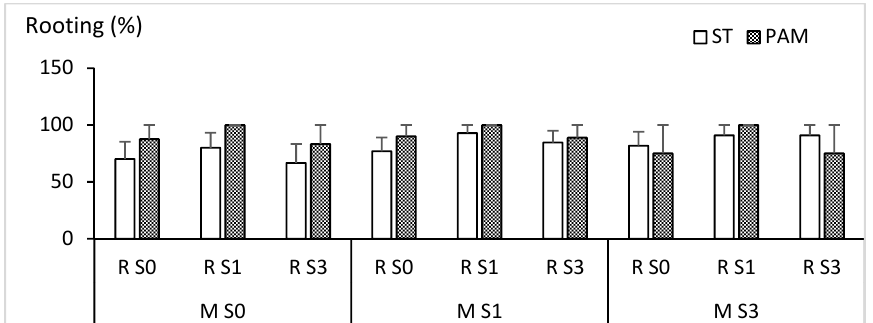
Figure 12. Shoots of CBP cultured in RITA© with 0–3% sucrose in ST or PAM conditions and rooted in rockwool cubes soaked with 0–3% sucrose. ST: standard conditions and PAM: photoautotrophic conditions. M S0, M S1 and M S3: sucrose percentage (0, 1 or 3%) of the multiplication medium in RITA© bioreactors. R S0, R S1 and R S3: sucrose percentage (0, 1 or 3%) of the rooting expression medium.